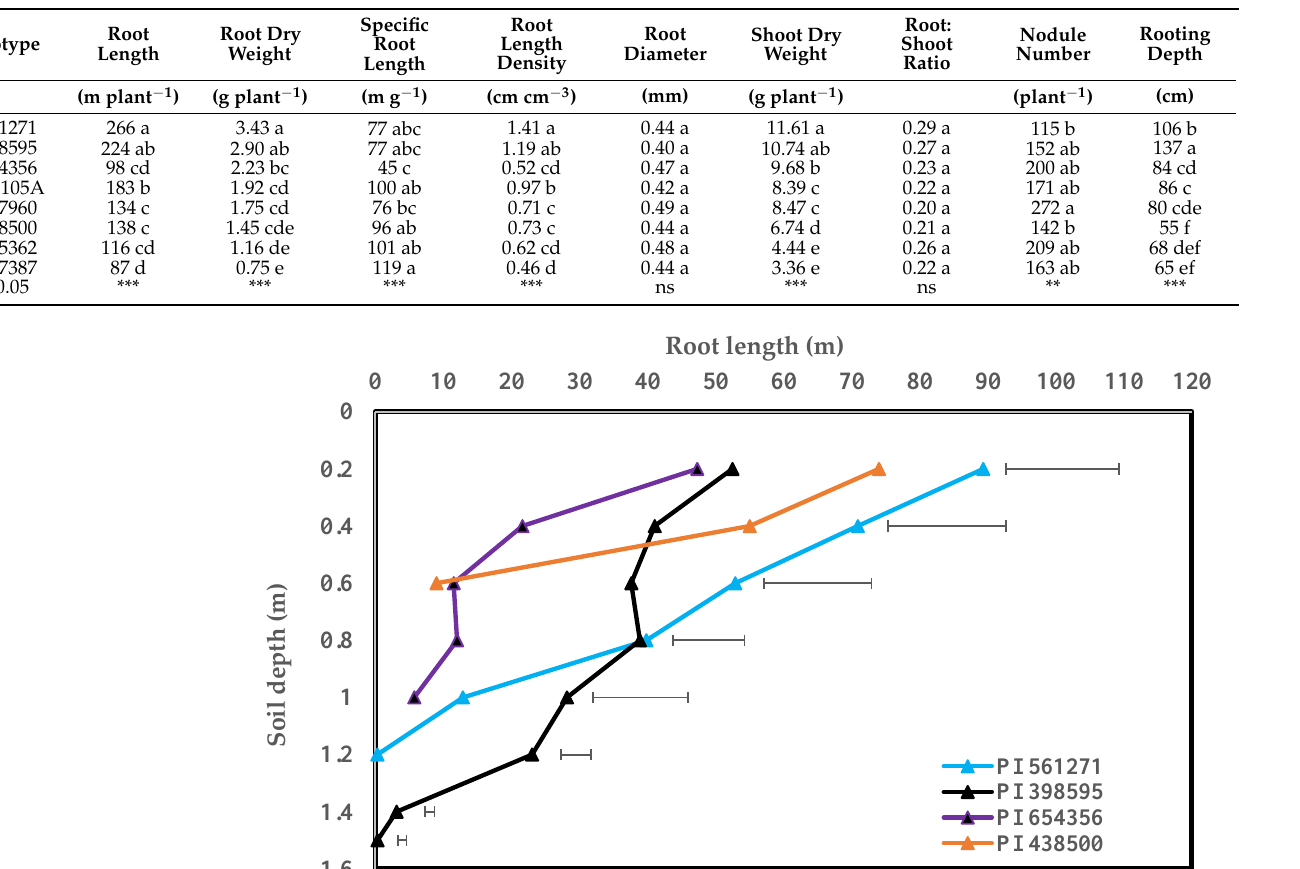
Table 2. Root traits of eight soybean genotypes grown in 1.5 m-deep rhizoboxes. Values are the mean of three replicates (two plants per rhizobox). Means followed by different letters in the same column differ significantly at p < 0.05 using Tukey’s honest significance difference (HSD). ns: not significant, ** and *** indicate significant differences among genotypes at p < 0.01 and p < 0.001, respectively.